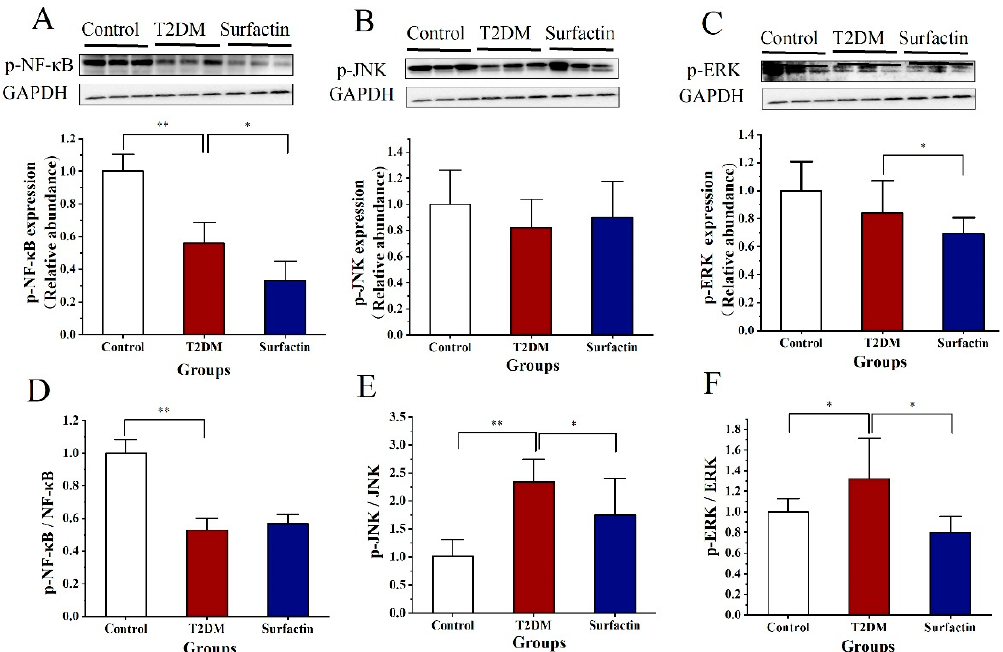
Figure 6. Effect of surfactin on colon inflammation in HFD/STZ-induced T2DM mice. The control group represents normal mice fed a basic diet, the T2DM group represents mice with T2DM induced by a 60% fat diet and 30 mg/kg body weight STZ, and the surfactin group represents T2DM mice treated with 80 mg/kg body weight surfactin. The levels of p-NF- κ B ( A ), p-JNK ( B ), p-ERK ( C ), p- NF- κ B/NF- κ B ( D ), p-JNK/JNK ( E ) and p-ERK/ERK ( F ). * indicates significant differences at p < 0.05, ** indicates significant differences at p < 0.01.